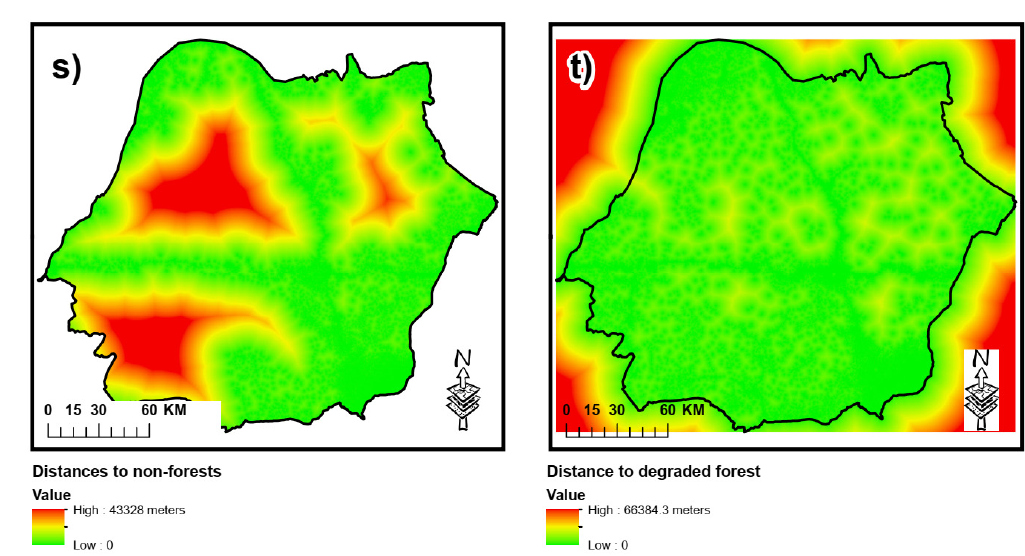
Figure 3. Maps of explanatory variables for deforestation. ( a ) distance to agricultural areas; ( b ) rural complex; ( c ) distance to rural complex; ( d ) distances to built-up areas; ( e ) distances to major center; ( f ) forest concessions; ( g ) distance to mining squares; ( h ) mining square; ( i ) distance to national road; ( j ) distance to provincial road; ( k ) distance to local road; ( l ) population density; ( m ) protected areas; ( n ) agricultural zones delimited; ( o ) community management; ( p ) elevation; ( q ) slope; ( r ) distance to watercourses; ( s ) distances to non-forests; ( t ) distance to degraded forest. Transitions